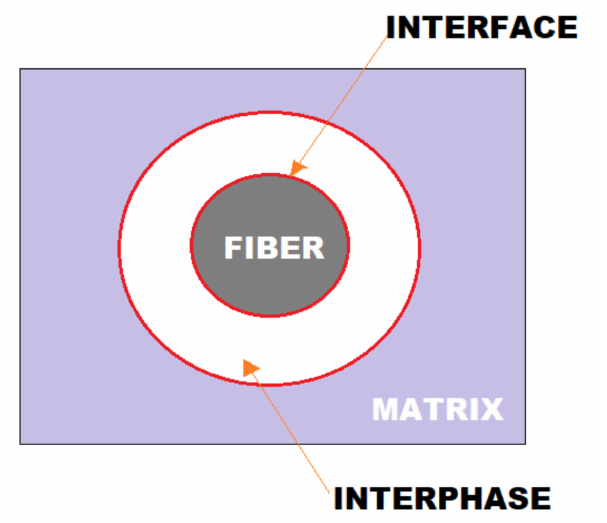
Figure 1. Basic scheme representing interface and